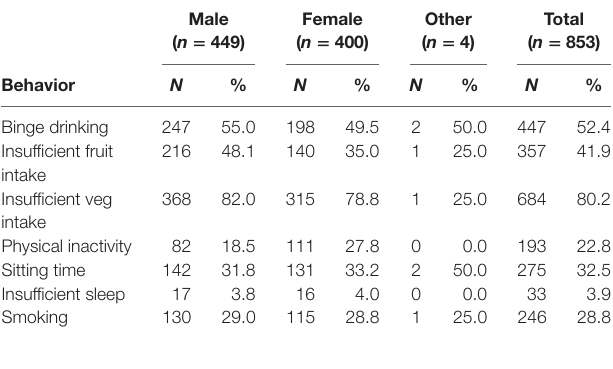
TaBle 4 | Prevalence of lifestyle risk behaviors by gender.